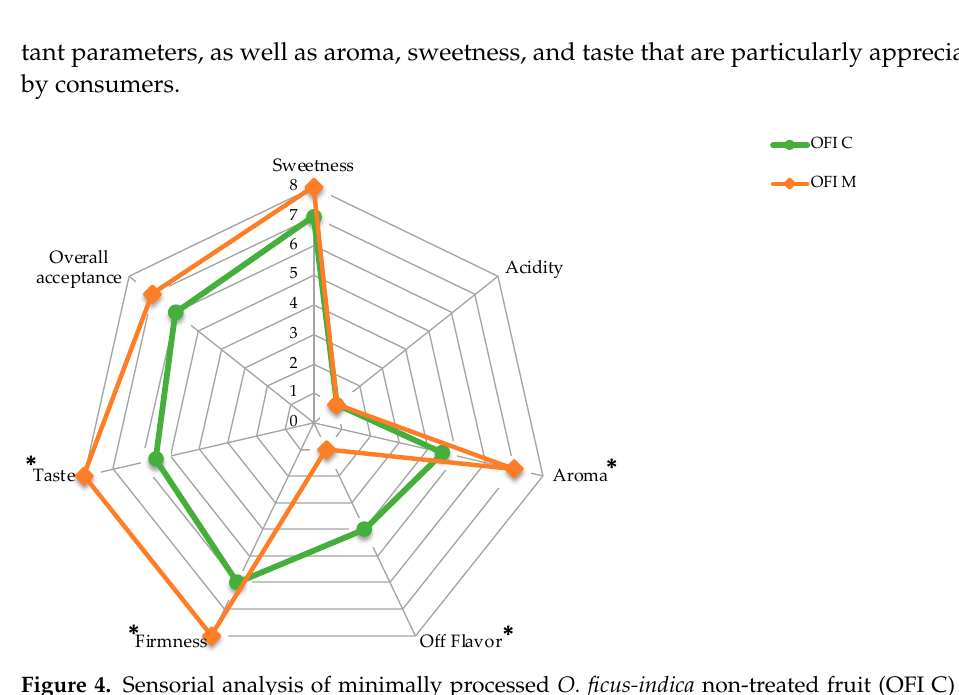
Figure 4. Sensorial analysis of minimally processed O. ficus-indica non-treated fruit (OFI C) and treated fruits with mucilage (OFI M) after 3 days of cold storage at 5 ◦ C. * indicate significant differences (Tukey’s test at p ≤ 0.05) between the treatments (OFI C and OFI M, n = 5 ).